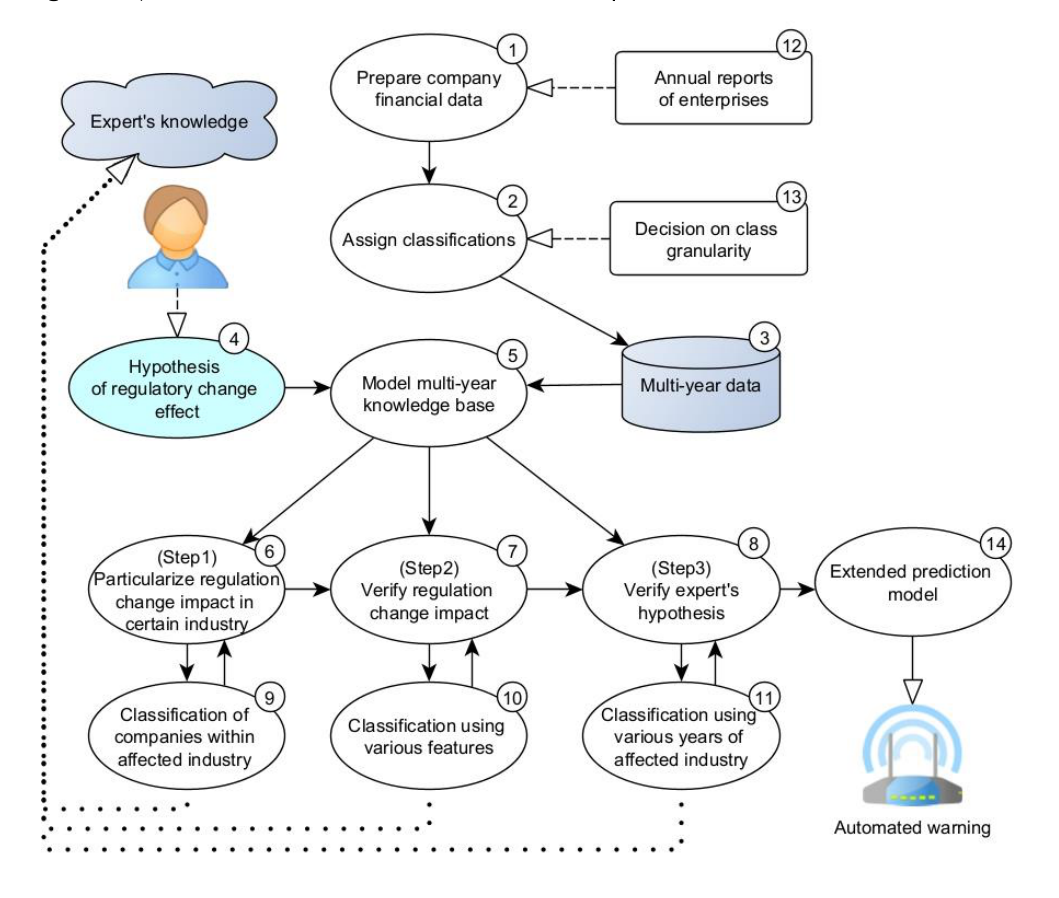
Figure 5. Extended model (Part II) – the machine learning